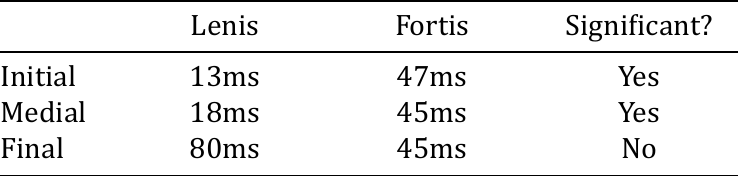
Table 6: Fortis-lenis plosive release duration (average) and